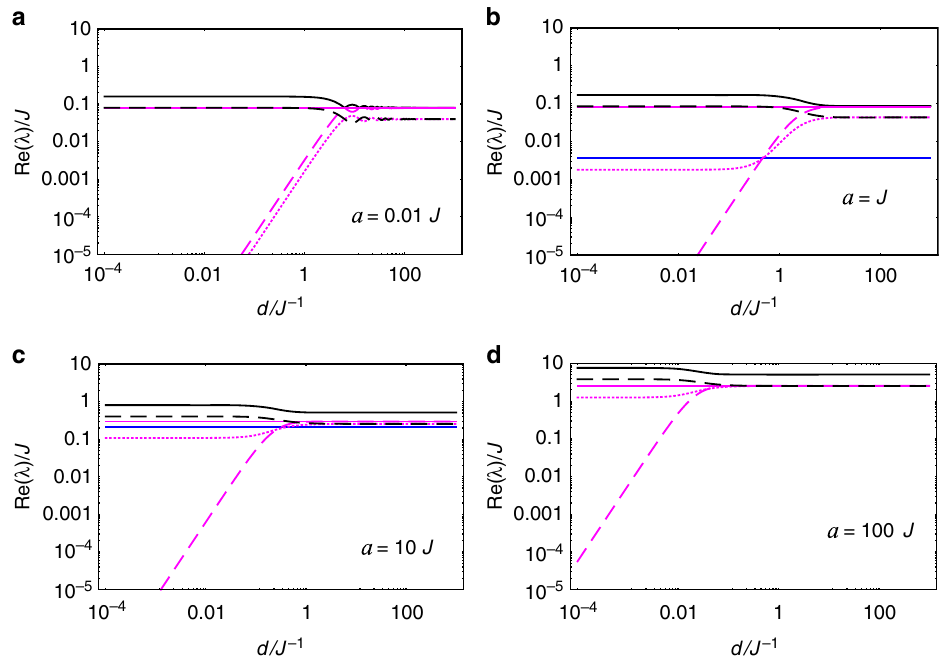
Fig. 3 Spin-separation dependence of relaxation/decoherence rates of the spin system with equal proper accelerations. We plot the decay rates (normalized by q 2 ), Re( λ k ) (using same style code as in Fig. 2), of the modes ^ ρ k , as functions of the distance d between the spins, for different accelerations a . Note that for any a > 0, the relaxation rate of mode ^ ρ goes to zero as d → 3